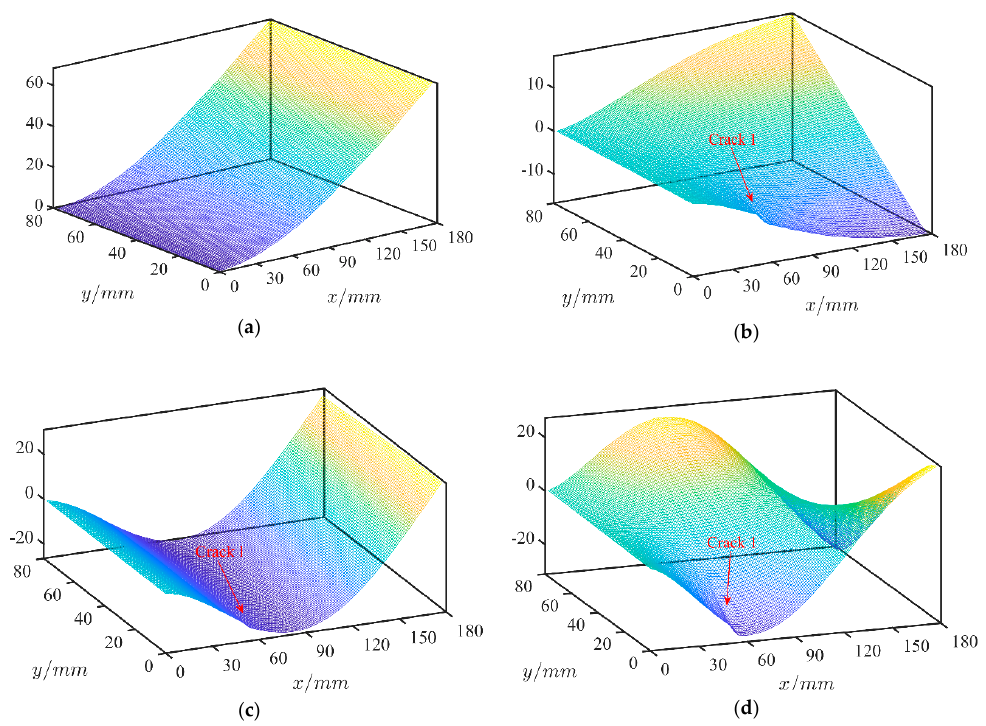
Figure 7. The first four mode shapes of a single crack plate using uniform-rate scanning CSLDV. ( a ) The first bending mode at 49.02 Hz. ( b ) The first torsion mode at 237.70 Hz. ( c ) The second bending mode at 311.52 Hz. ( d ) The second torsion mode at 781.25 Hz.